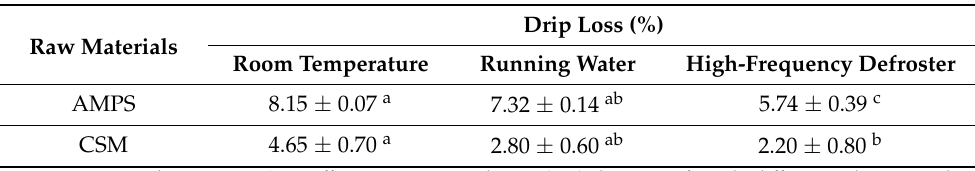
Table 2. Drip loss analysis of frozen adductor muscle of the pen shell (AMPS) and common squid meat (CSM) under different